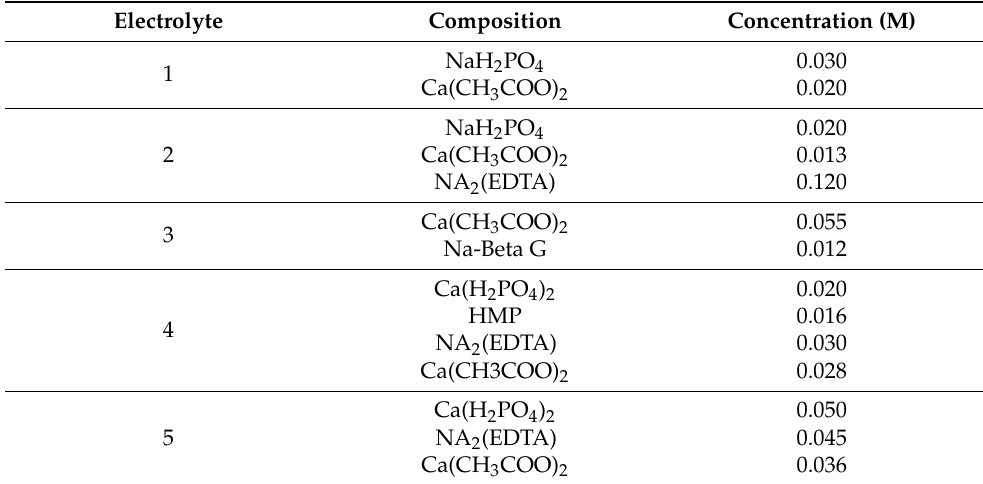
Table 2. Composition and concentration of electrolytes employed. Adapted from [101]. Electrolyte